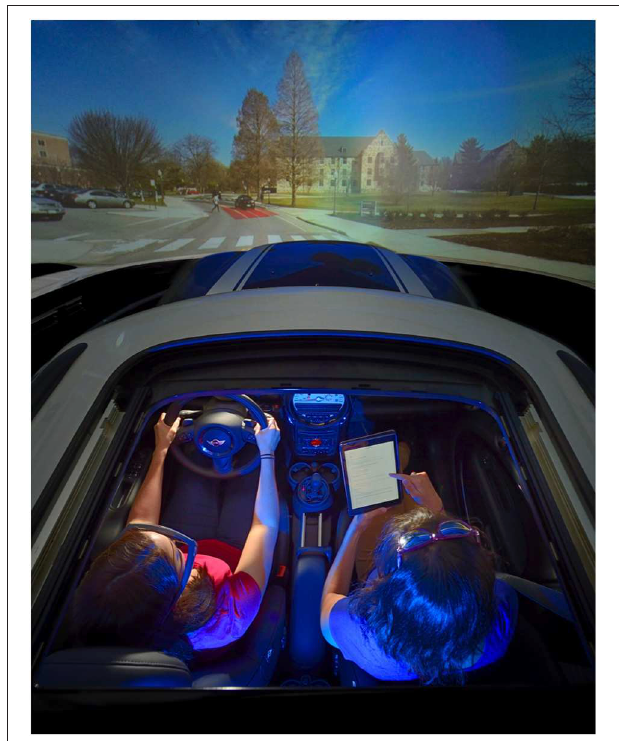
FIGURE 1 | A bird’s eye view of the Mini Cooper half cab with participant and experimenter. While the work presented herein focuses on CG-based driving capabilities, the testbed also supports alternative forms of driving studies (e.g., video-based).